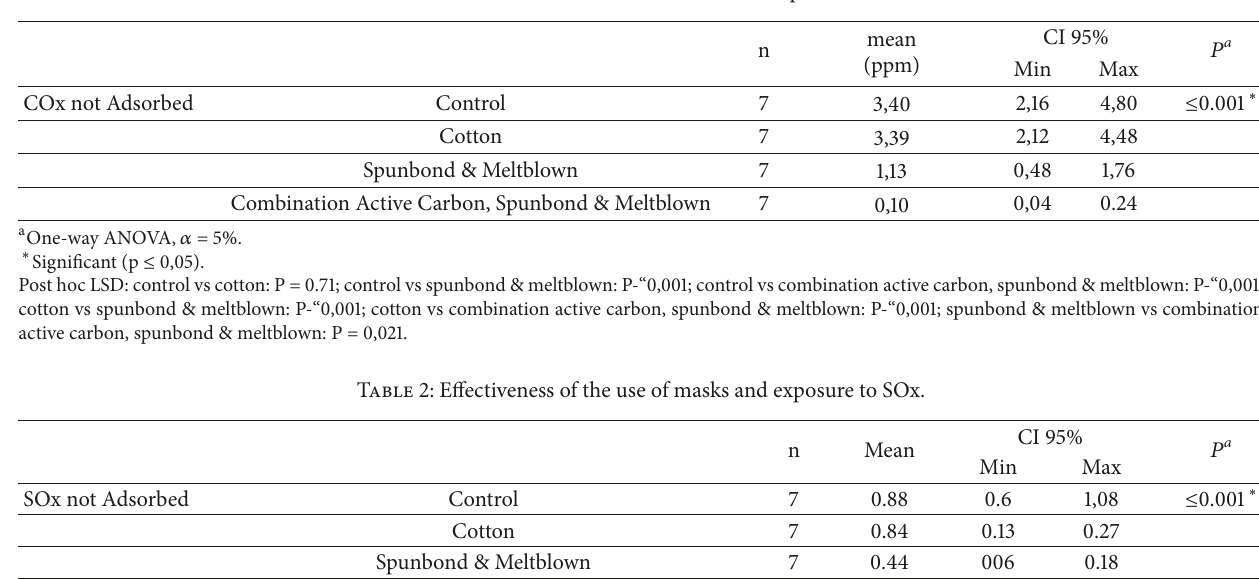
Table 1: Effectiveness of the use of masks and exposure to COx.